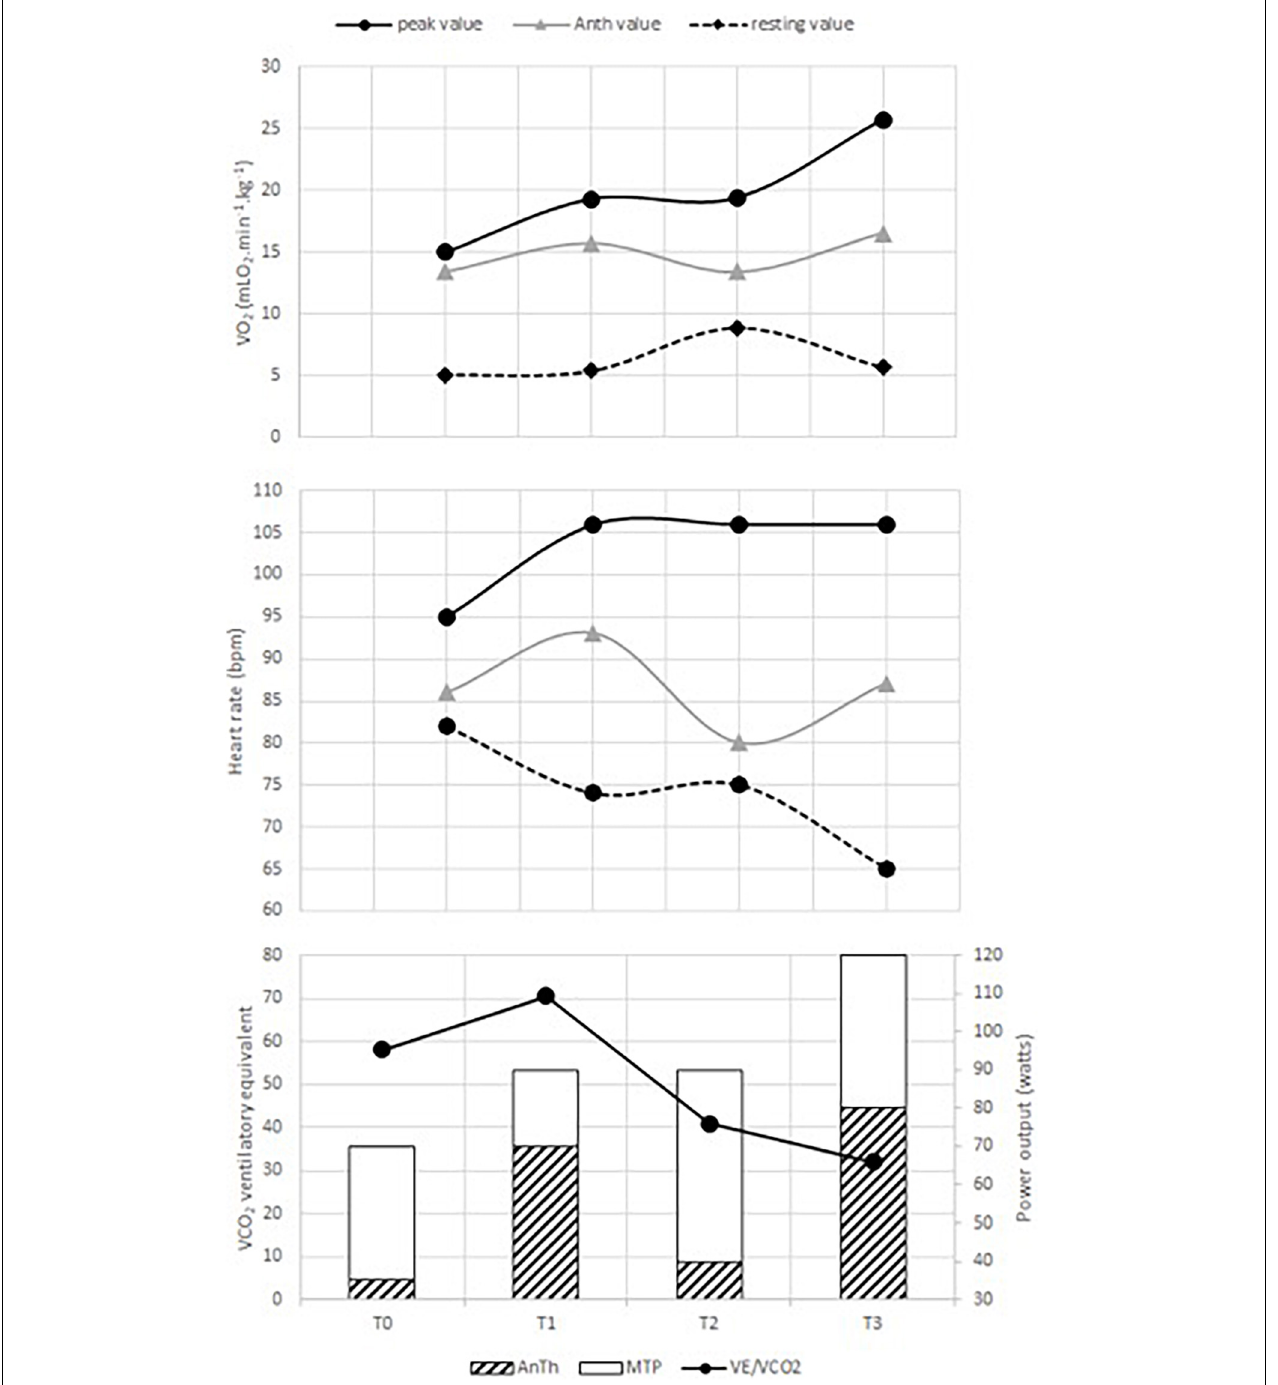
FIGURE 1 | Changes in cardiorespiratory responses induced by the exercise-based cardiac rehabilitation (ECR) program. AnTh is the acronym for anaerobic threshold. ˙ VO 2 , V E /VCO 2 , HR, and MTP represent oxygen uptake, ventilatory equivalent to CO 2 , heart rate, and maximal tolerated power, respectively. T 0 is the time of the initial evaluation, T 1 and T 2 , the times of the intermediate evaluation (after the first 20 and 40 sessions), and T 3 , the time of the final evaluation.